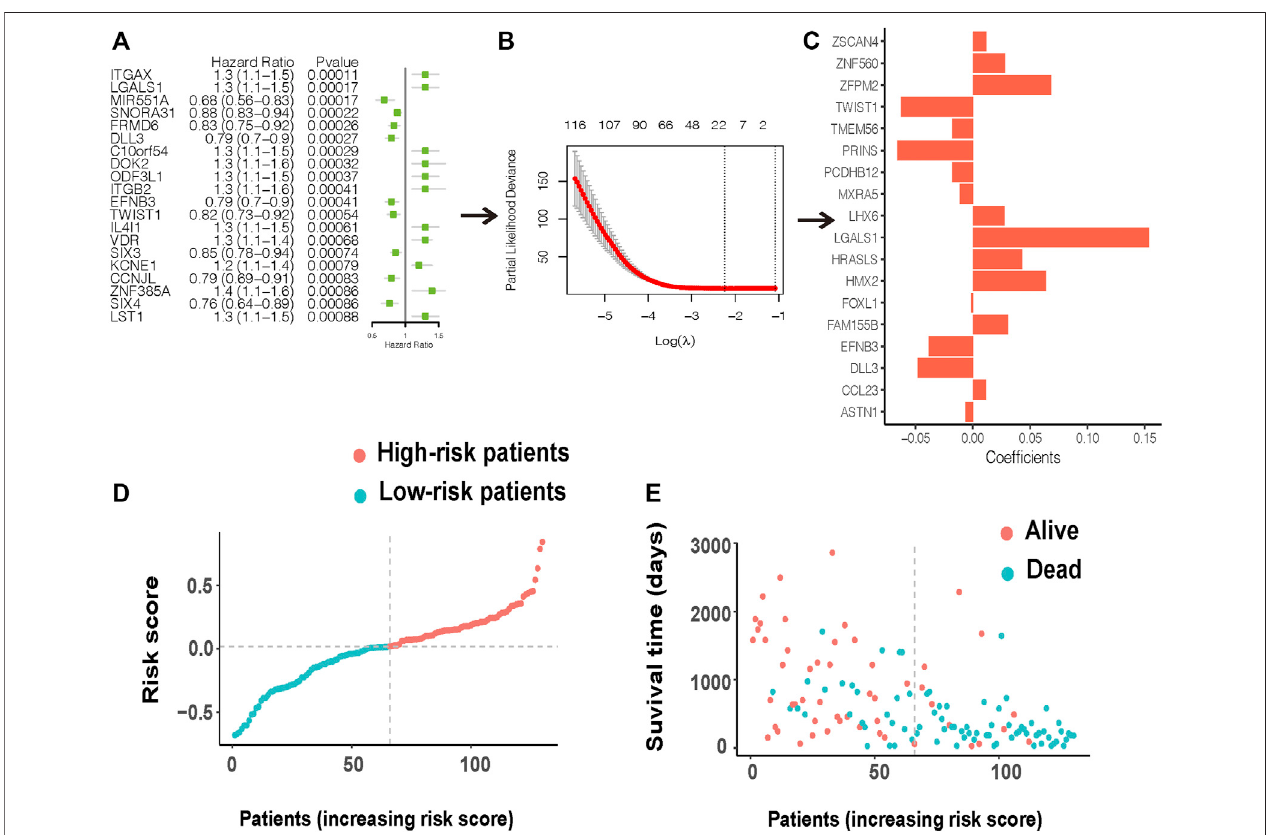
FIGURE 3 | Construction of a prognostic risk model. (A) A forest plot of the top 20 prognosis-related DEGs. (B) LASSO variable screening process. (C) 18 prognostic genes were eventually selected after LASSO regression to establish a prognostic model. (D) Distribution of the risk score for the AML patients. (E) Patients ’ status based on the risk